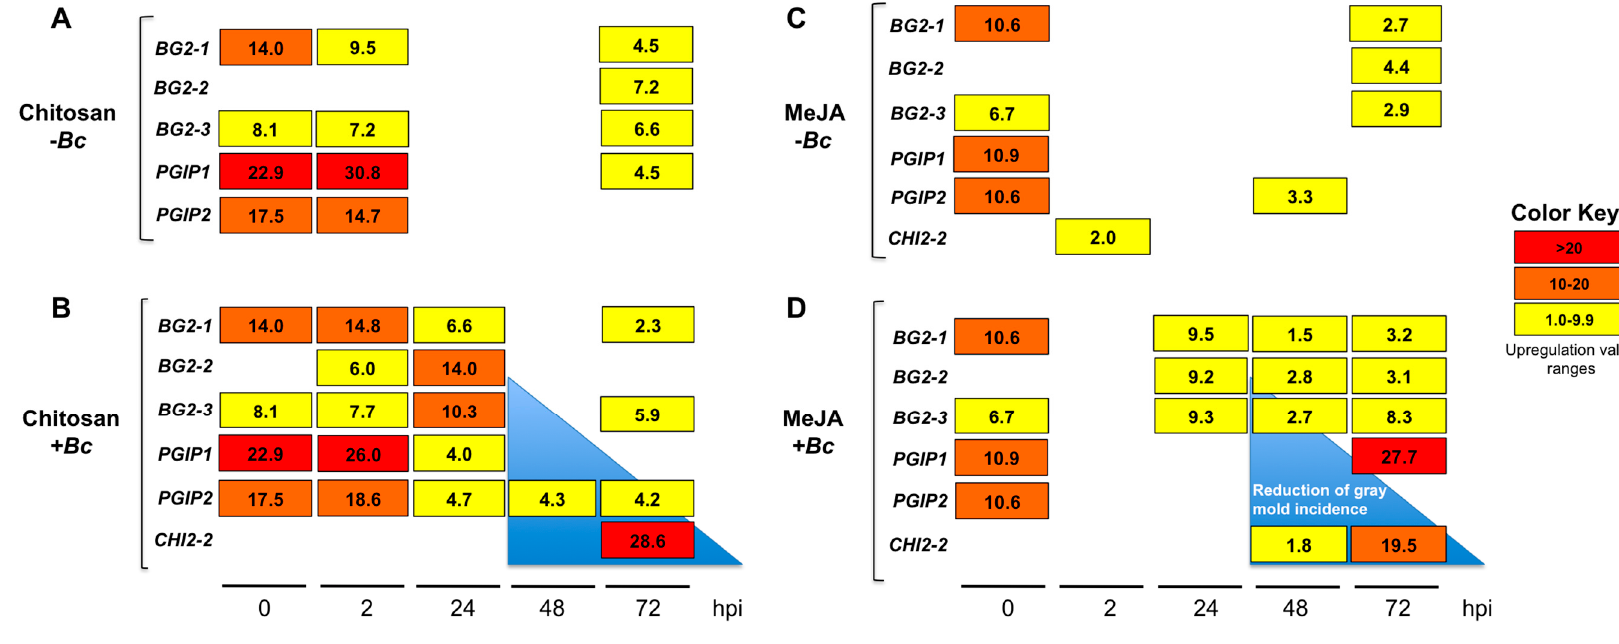
Scheme 2. Temporal sequence of upregulation of PR and PGIP genes and gray mold incidence in chitosan- and MeJA-treated Fragaria chiloensis fruit at different hours post inoculation (hpi). Upregulation pattern of defense genes in Chitosan – Bc ( A ), Chitosan + Bc ( B ), MeJA – Bc ( C ), and MeJA + Bc ( D ) treatments at 0, 2, 24, 48, and 72 h post inoculation (hpi). Values in each box indicate the fold-change of upregulation for each gene with respect to the value of the control treatment according to the color key shown. Blue triangles represent the reduction of gray mold incidence observed in Chitosan + Bc and MeJA + Bc with respect to Control + Bc treatment. For experimental details see the Materials and Methods Section. PR genes: BG2-1 , β -1,3-glucanase 2-1; BG2-2 , β -1,3-glucanase 2-2; BG2-3 , β -1,3-glucanase 2-3; CHI2-2 , chitinase 2-2; CHI3-1 , chitinase 3-1. PGIP genes: PGIP1 , polygalacturonase inhibiting protein 1; PGIP2 , polygalacturonase inhibiting protein 2. MeJA: methyl jasmonate.